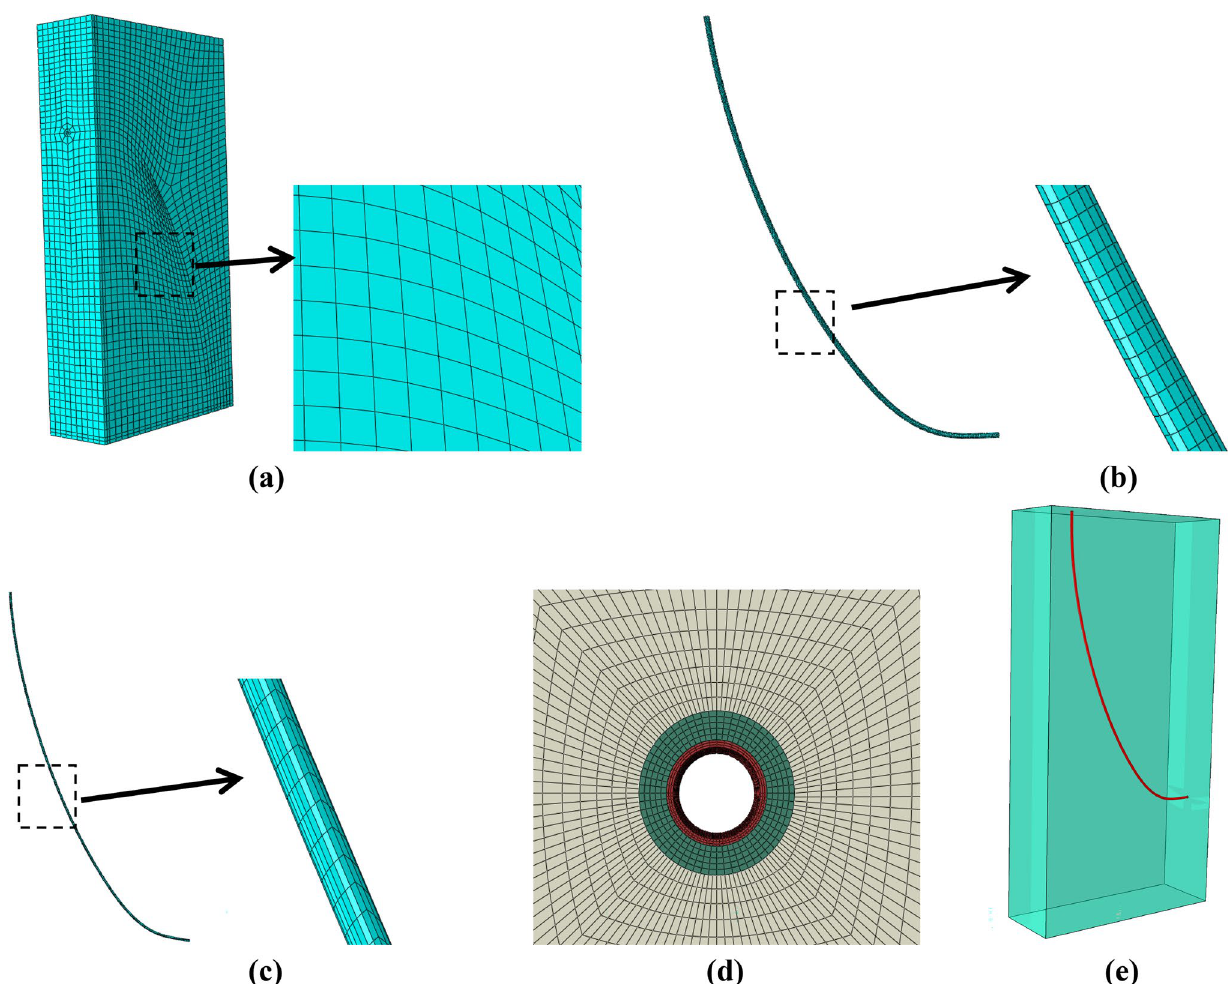
Fig. 7 Three-dimensional finite element model of the bending sections. a Stratum grid. b Cement grid. c Casing grid. d Two-dimensional plan of casing–cement–formation. e Three-dimensional combination model of casing–cement–formation in the bending